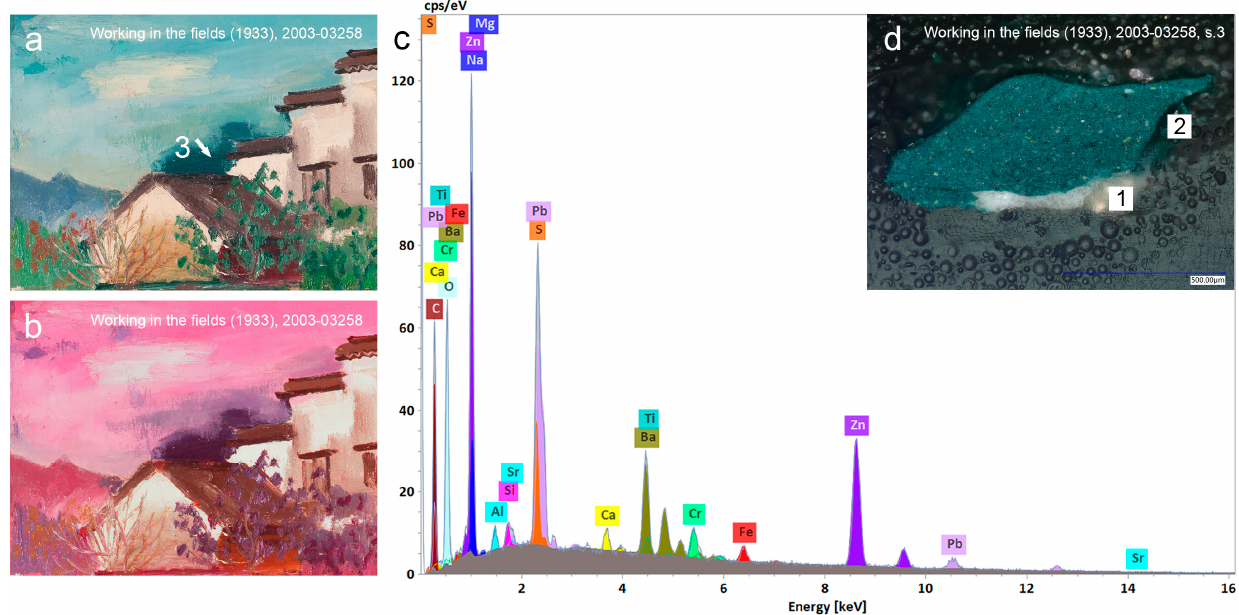
Figure 9. Detail of Working in the fields , 1933, photographed in VIS showing the location from which sample 3 was extracted ( a ) and IRFC image of the same area ( b ). SEM-EDS spectra of the blue paint, extracted from the sampling spot ( c ) and corresponding optical microscopy image of the cross-section of sample 3 at 200× magnification with the marked area of analysis in layer 2 ( d ). A blue colour recorded as dark violet in IRFC ( b ) and the presence of Fe and Cr ( c ) in layer 2 ( d ) suggested a mixture composed predominantly of Prussian blue and viridian.